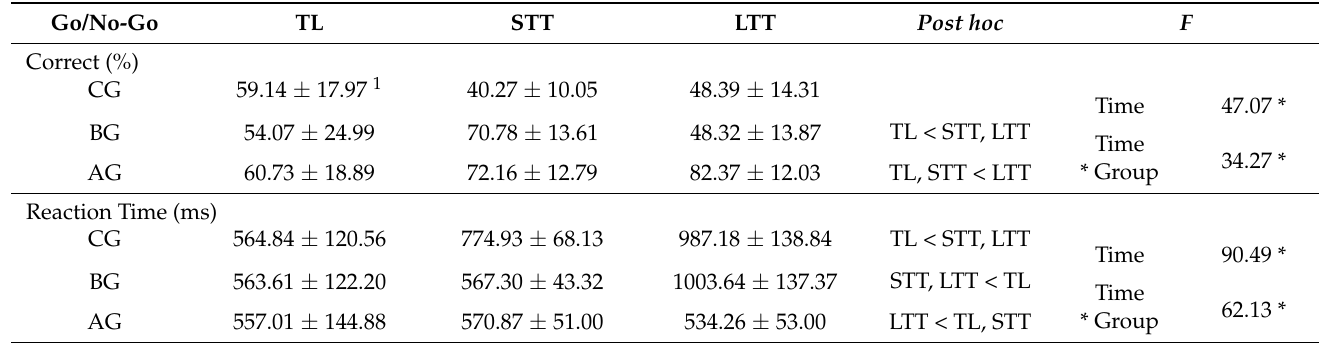
Table 4. Change of attention of cognitive function by area (N = 45).